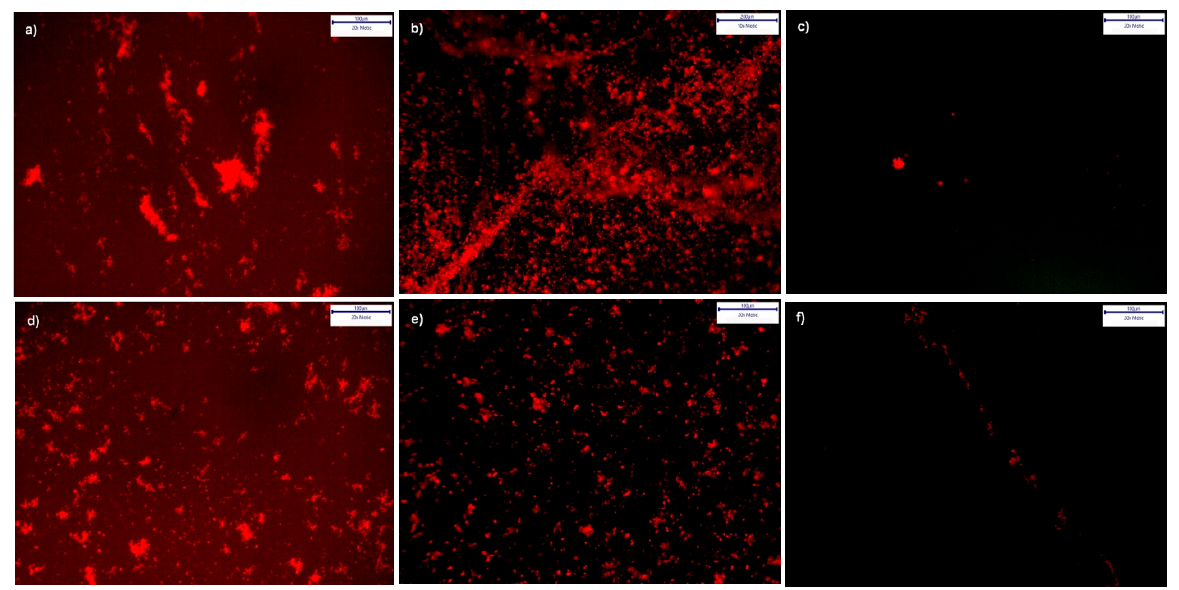
Figure 8. Biofilm formation on specimen surfaces: ( a – f ) show fluorescence micrographs of PI-stained plaque cultures after 72 h incubation on coverslips ( a , d ), TiCP (ar) ( b , e ) and polySBMA coatings ( c , f ).